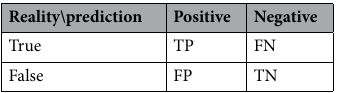
Table 5. Model prediction